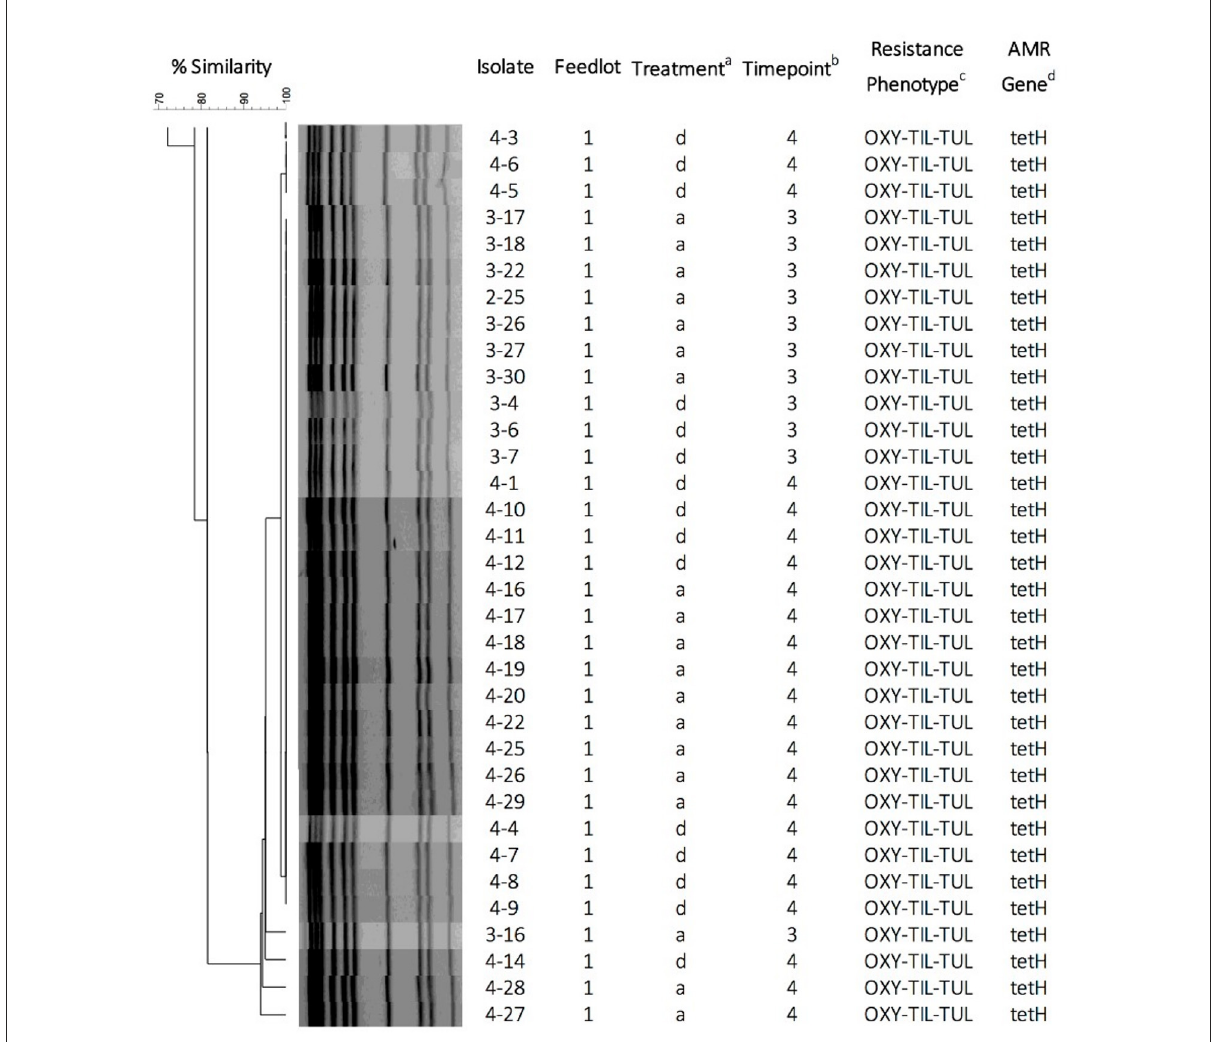
FIGURE5 Pulsed-field gel electrophoresis dendrogram, cluster analysis, and antimicrobial susceptibility for 34 P. multocida isolates representing pulsogroup 10 (90% similarity threshold cutoff value). P. multocida were digested with ApaI. The dendrogram was created by UPGMA cluster analysis using Dice coefficients of similarity with optimization and tolerance settings of 0.5 and 1.0%, respectively. a Treatment: d, calves directly transported from cow-calf ranch to feedlot; a, calves transported to and co-mingled at auction markets before placement in a feedlot; b Sampling timepoints: 3 = day 9; 4 = day 30; c Phenotypic resistance against antimicrobials OXY (oxytetracycline), TIL (tilmicosin), and TUL (tulathromycin). d Antimicrobial resistance genes detected by